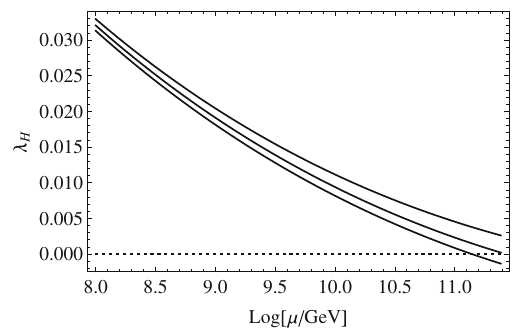
Fig. 5 RG running of λ H for μ < M I (cid:2) 2 × 10 11 GeV, for m D = 2 TeV and m T = 5 × 10 4 TeV. The solid lines from top to bottom correspond to m 0 [ GeV ] = 35, 55, and 60, respectively. The dotted line depicts λ H = 0